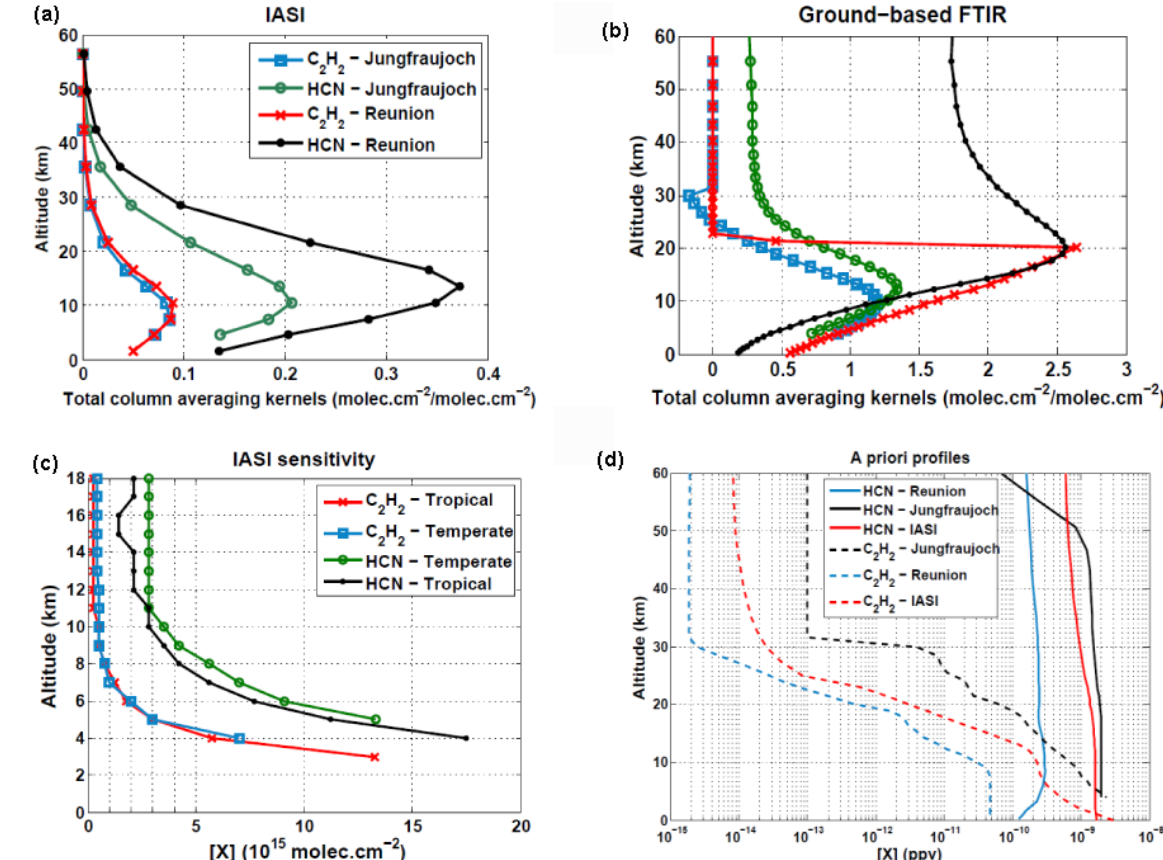
Fig. 3. (a) Total column averaging kernels of IASI and (b) ground-based FTIR in molecules cm − 2 for C 2 H 2 at Jungfraujoch (blue squares and lines), HCN at Jungfraujoch (green circles and lines), C 2 H 2 at Reunion and HCN at Reunion (black dots and lines). (c) Detectable concentrations by IASI as function of altitude for C 2 H 2 in a temperate atmosphere (blue squares and line), C 2 H 2 in a tropical atmosphere (red crosses and lines), HCN in a temperate atmosphere (green circles and lines) and HCN in a tropical atmosphere (black dots and line). (d) A priori profiles used in the retrievals for Reunion Island (blue lines), Jungfraujoch (black lines) and IASI (red lines) for HCN (solid lines) and C 2 H 2 (dotted